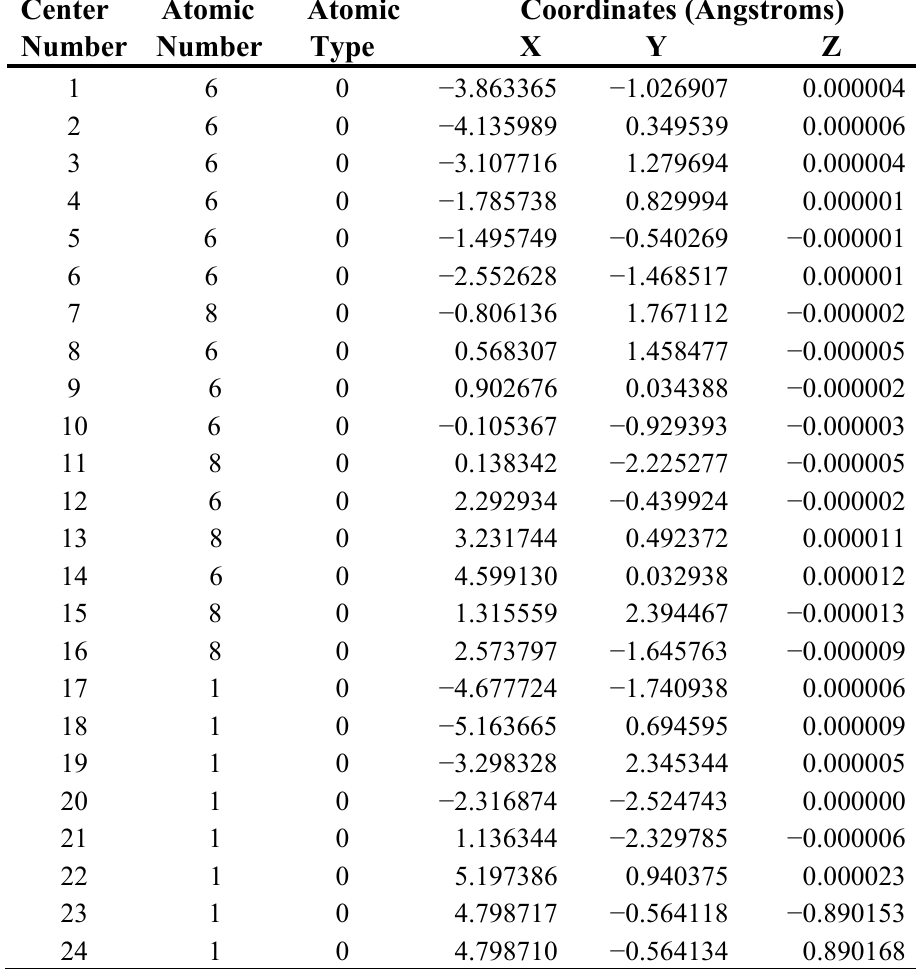
Table S1. XYZ coordinates for tautomer